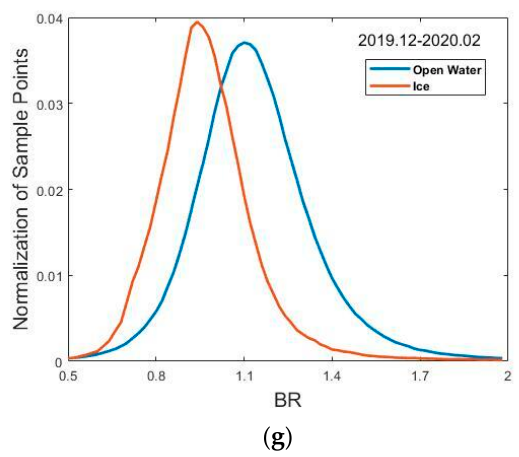
Figure 2. Normalized distribution of the characteristic parameters over open seawater and ice in the Antarctic; the period over which statistics were obtained was from December 2019 to February 2020. ( a ) σ 0 (dB), ( b ) σ 0 (dB), ( c ) standard deviations of HH measurements, ∆ σ 0 (dB), HH VV HH ( d ) standard deviations of VV measurements, ∆ σ 0 (dB), ( e ) polarization ratio of backscatter measure- VV ments PR , ( f ) backscatter dependence on incidence angle K VV , and ( g ) band ratio of VV backscatter measurements, BR